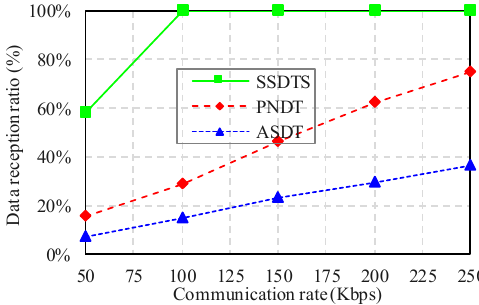
Figure 11. Data reception ratio of different methods.